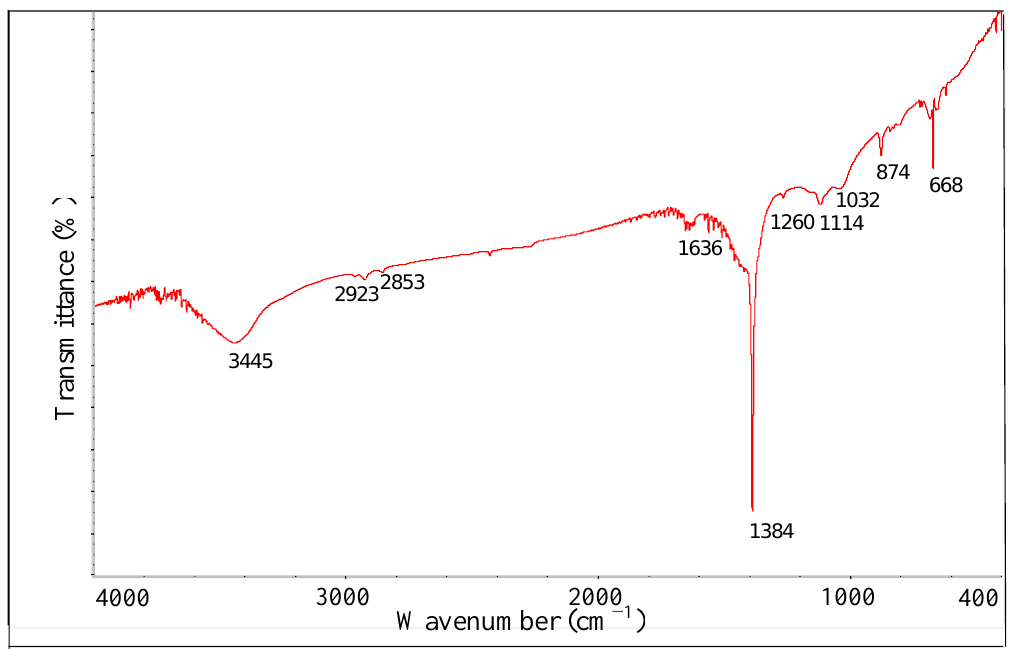
Figure 3. FTIR spectrum of biochar.